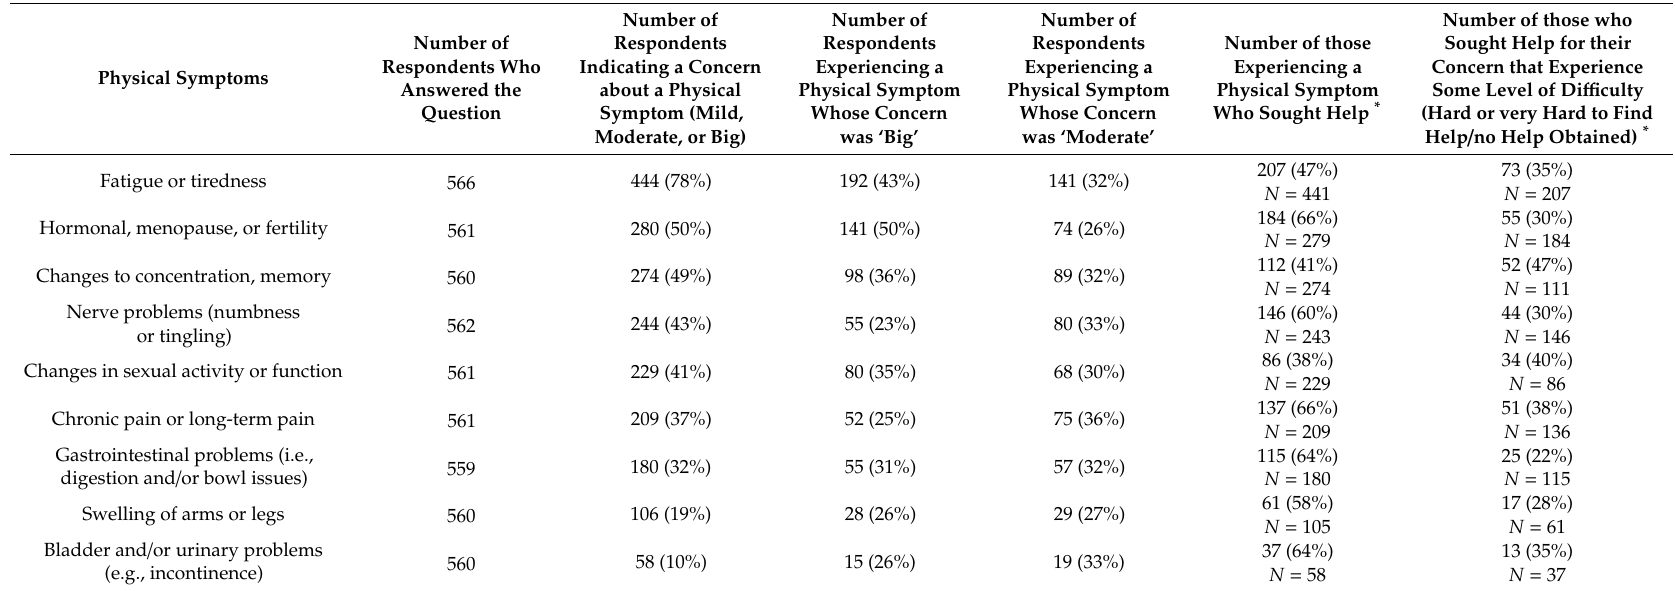
Table 2. Physical symptoms prevalent and ease of accessing help in AYA